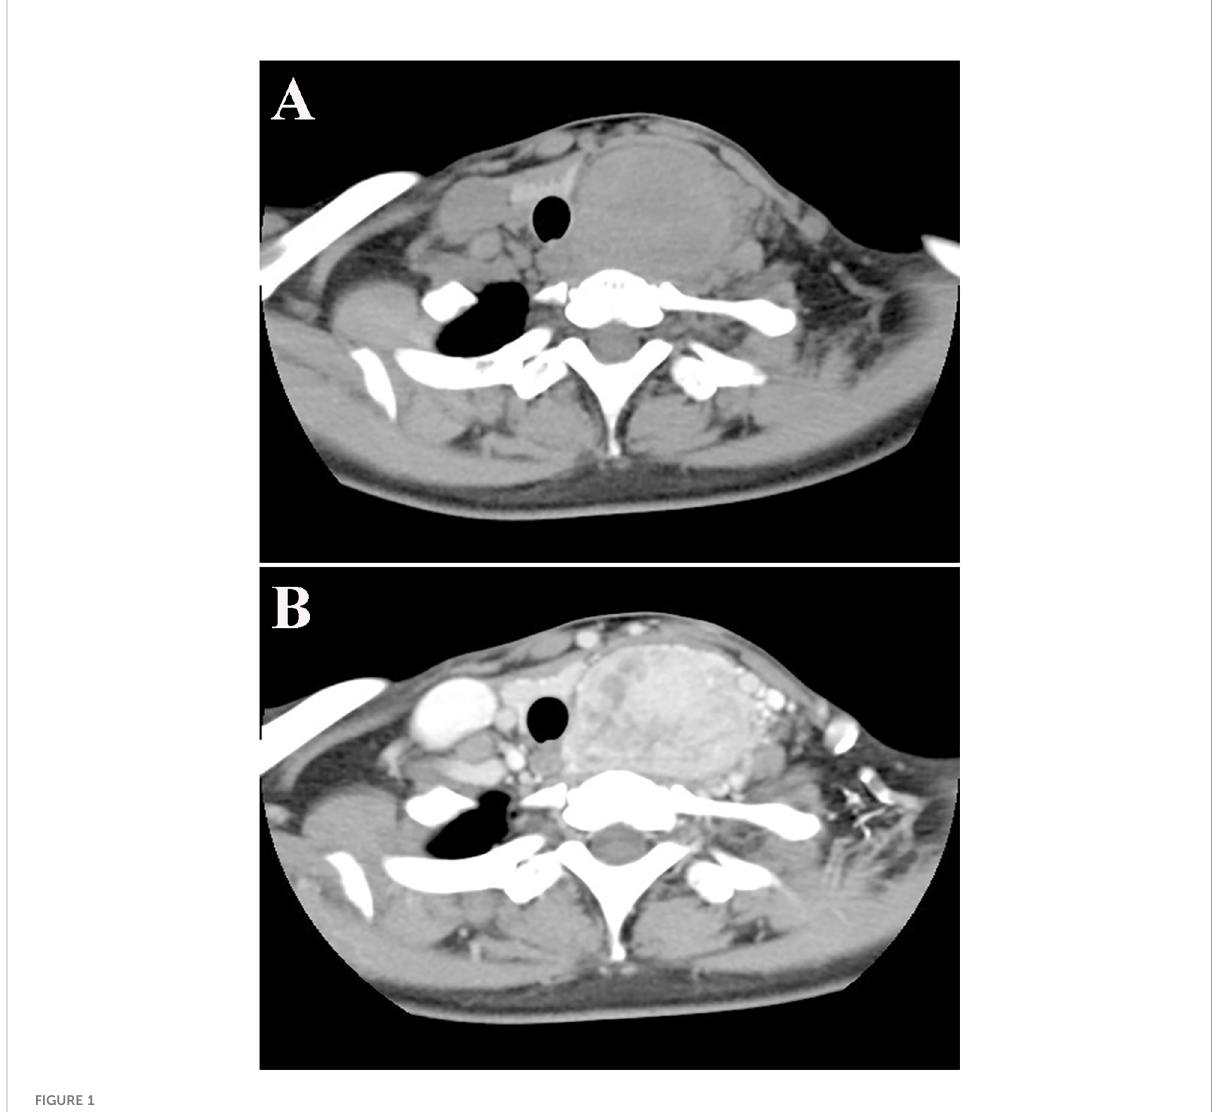
FIGURE 1 Cervical computed tomography scan (A, B)